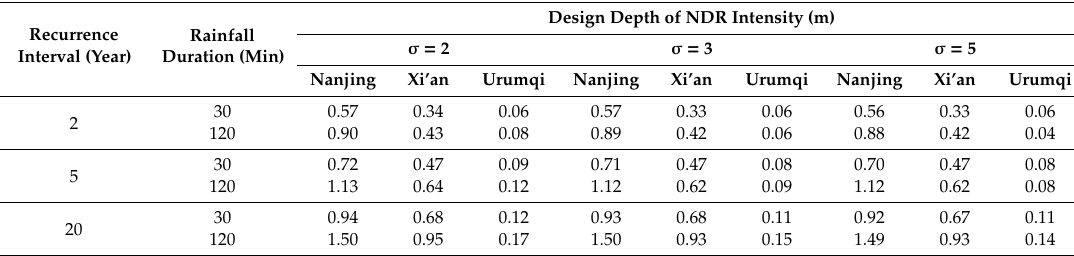
Table 2. Calculated design depth of LID device using NDR with di ff erent recurrence intervals. Recurrence Interval (Year)